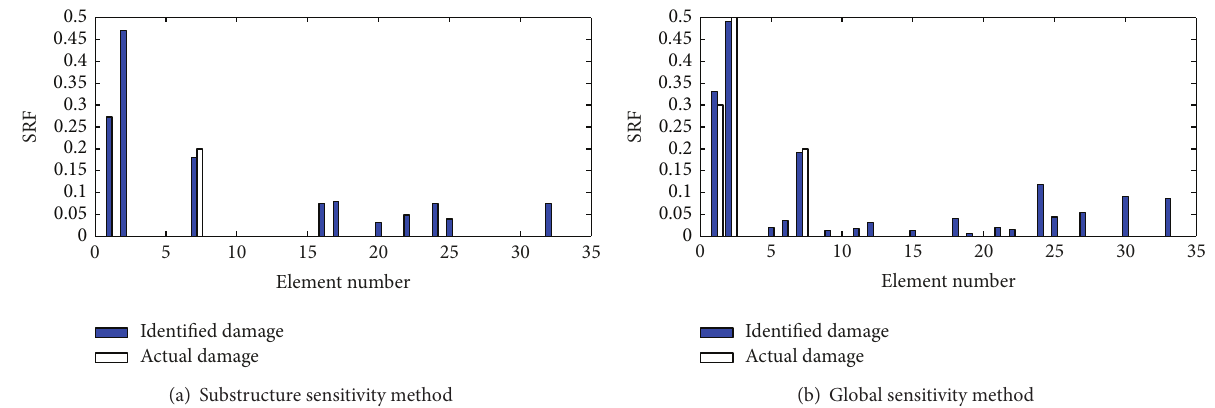
Figure 11: Damage detection results (Case